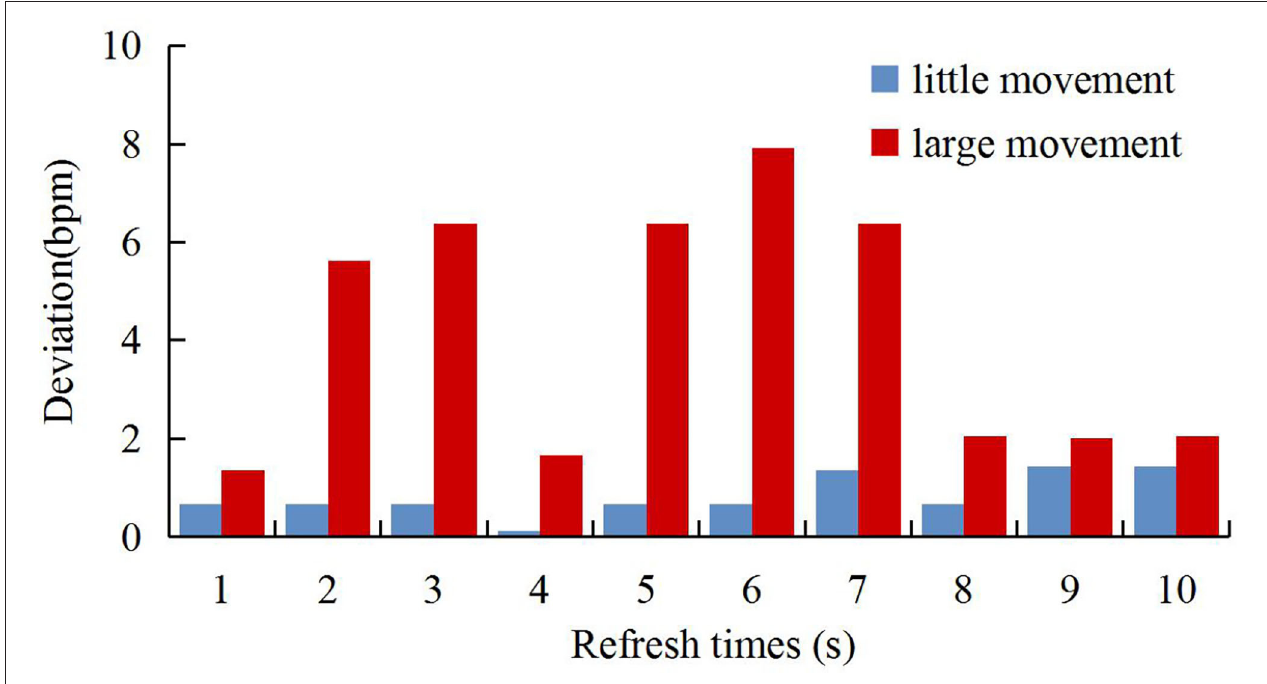
FIGURE 14 | The deviation under physical movement.